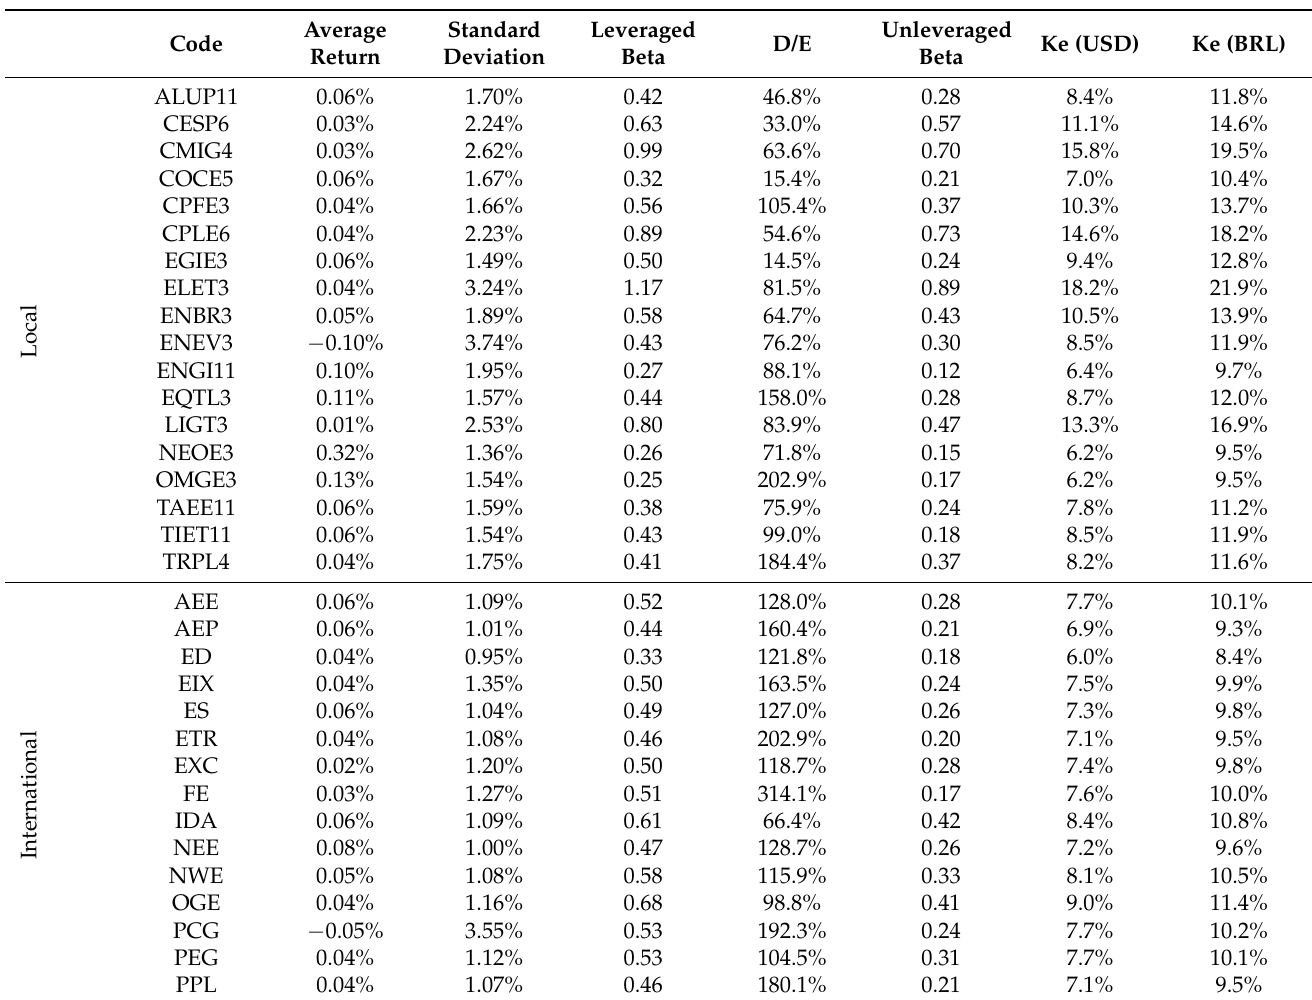
Table 2. Average financial results of local and international companies, from January 2011 to Decem- ber